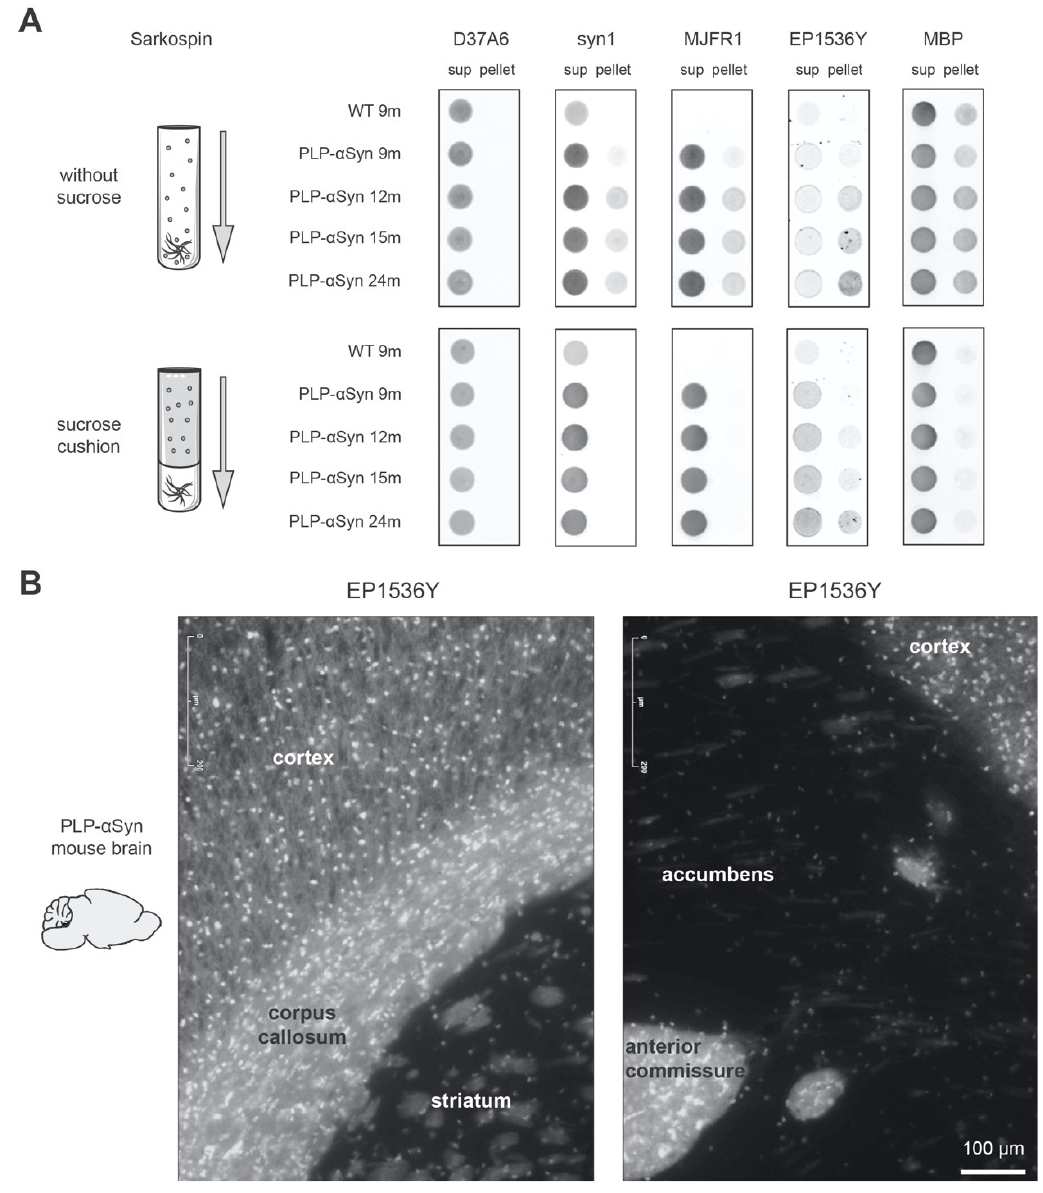
Figure 3. pS129-positive α -syn mono/oligomers co-sediment with MBP and are enriched in myelinated regions of the PLP- α Syn mouse brain. ( A ) Sedimentation analysis of the different species of α -syn found in WT or PLP- α Syn mouse brains with or without myelin floatation. Pooled 9 to 24 months-old mouse brain homogenates ( n = 3) were subjected to SarkoSpin normal procedure (with sucrose cushion, bottom ) or to the same procedure without myelin floatation sucrose cushion (without sucrose, top ). The content in endogenous murine α -syn (D37A6), total α -syn (syn1), human α -syn (MJFR1), pS129- α -syn (EP1536Y) and myelin basic protein (MBP) of SarkoSpin supernatant and pellet fractions were assessed by filter trap followed by immunolabelling with the respective antibodies. Pictures are representative of n = 2 independent Sarkospin procedures quantified in Supplementary Figure S3. ( B ) Representative pS129- α -syn immunofluorescence staining of six months-old PLP- α Syn mouse brain sections. Hyperphosphorylated forms of the protein are prominent in regions with long myelinated axons such as the corpus callosum and the anterior commissure.